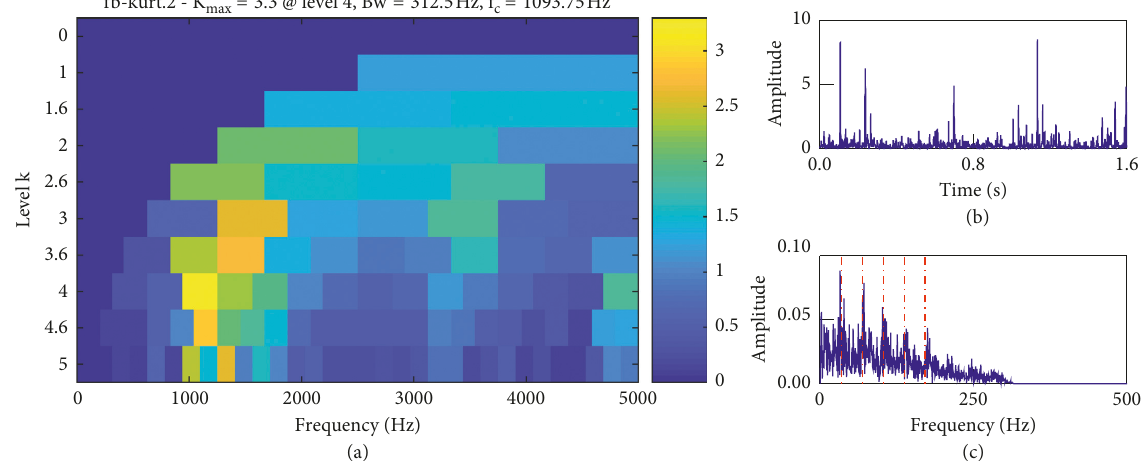
BPFO and its harmonics).